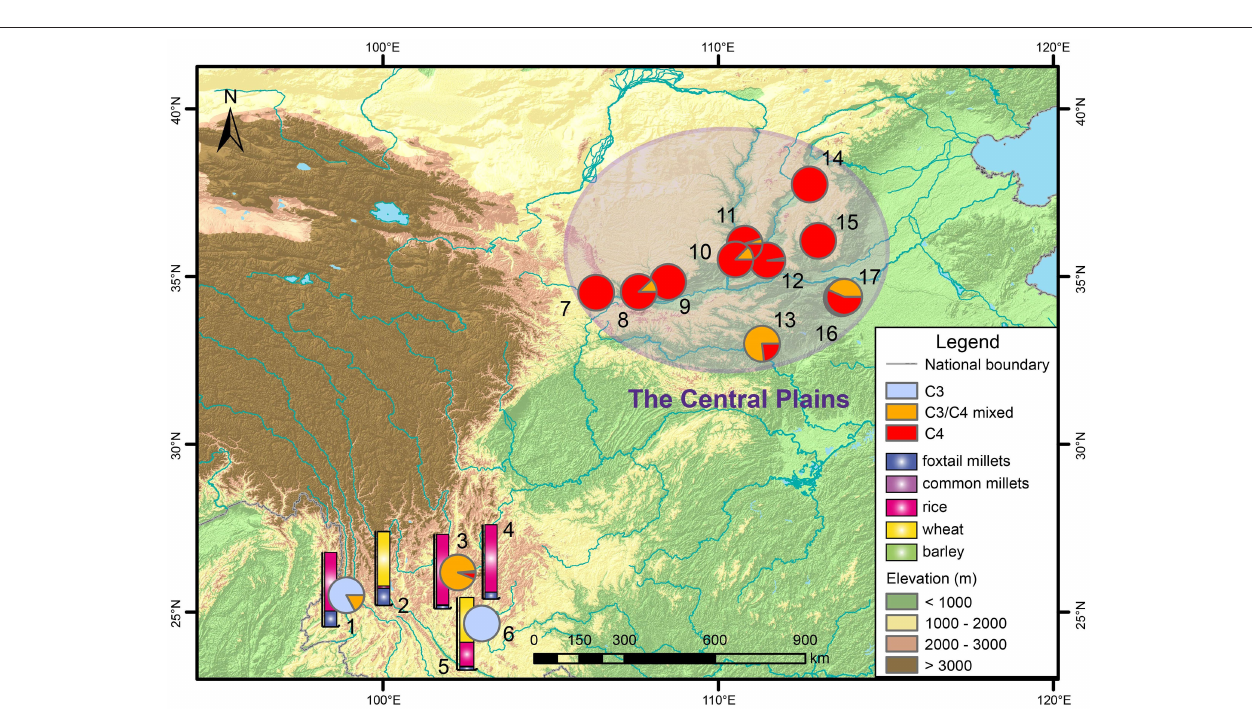
FIGURE 4 | Comparison of human C isotope values and frequency index of the crop remains at the Jiangxifen site and other contemporaneous sites in Yunnan (Xue, 2010; Zhang, 2011; Wang, 2014; Yao et al., 2015; Li and Liu, 2016; Li et al., 2016; Liu, 2016; Yang, 2016; Ren et al., 2017; Dal Martello et al., 2021 ) and the Central Plains ( Pei et al., 2008; Ling et al., 2010a,b; Chen, 2012; Hou et al., 2012; Dong et al., 2017; Lan, 2017; Zhou et al., 2017; Tang et al., 2018; Sun, 2019; Li et al., 2020): (1) Shilinggang; (2) Haimenkou; (3) Jiangxifen; (4) Yubeidi; (5) sites around Dian and Fuxianhu Lake (including Dayingzhuang, Hebosuo, Anjiang,